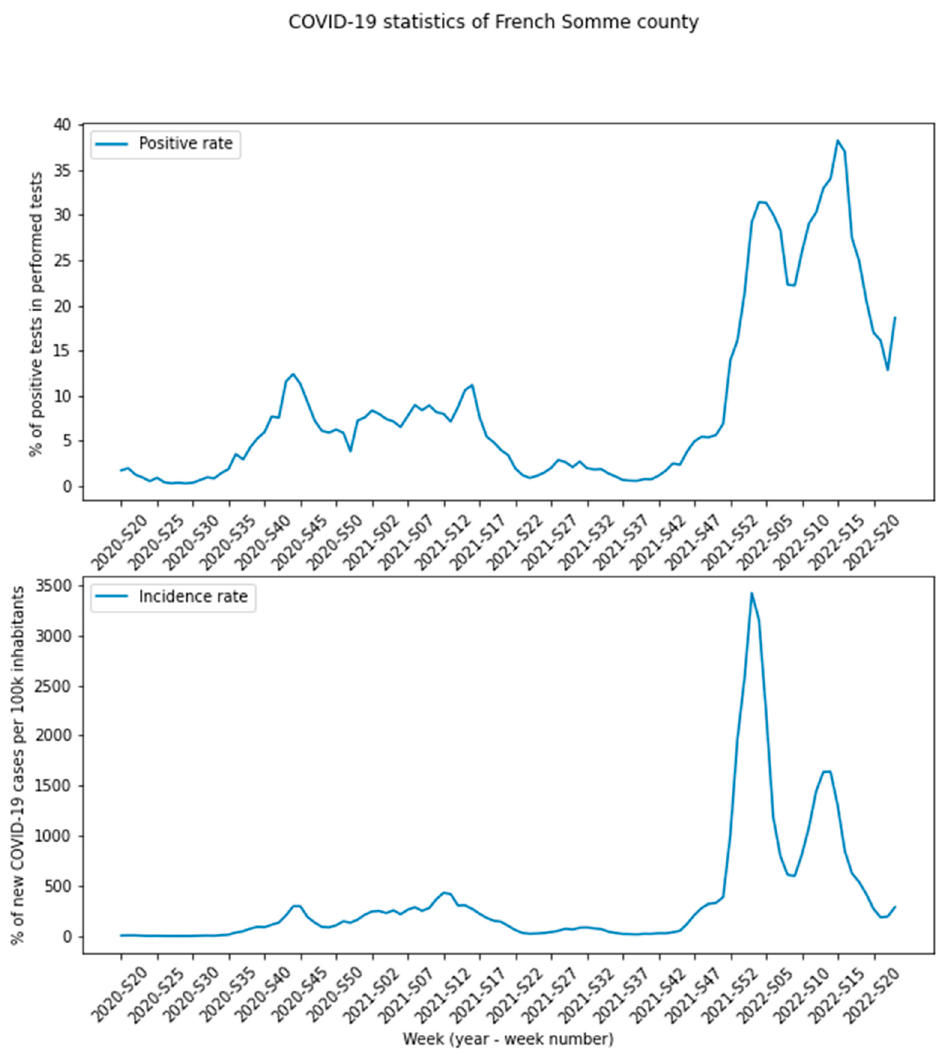
Figure 1. Changes over time in the PCR results in the Somme county of France. The data were extracted from data.gouv.fr, accessed on 1 July 2022 [20].